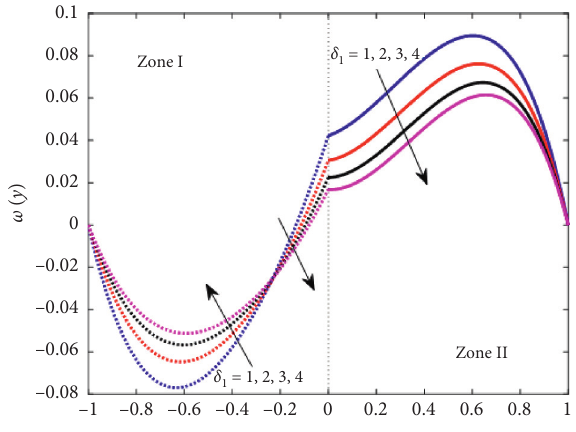
Figure 8: Microrotation profiles for various δ